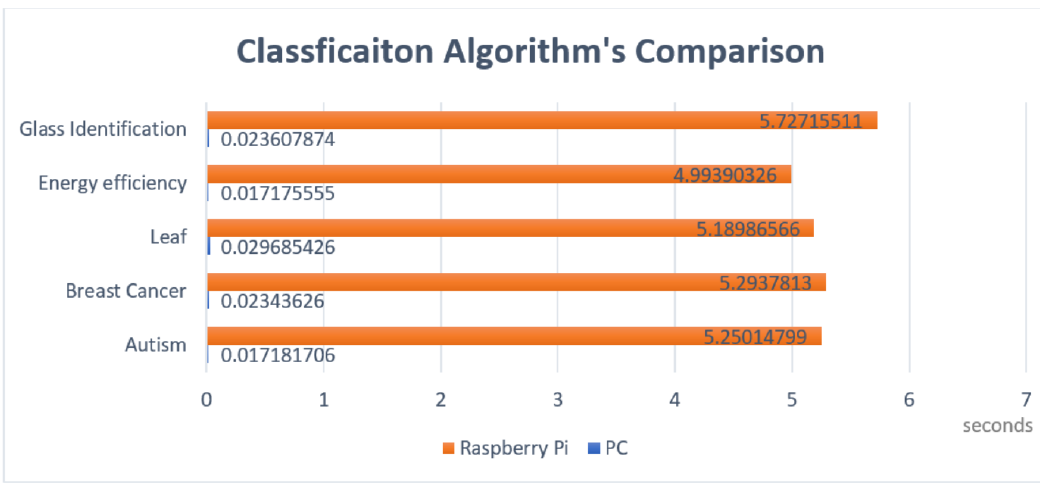
Figure 7. Random Forest-Execution Time-Raspberry vs.